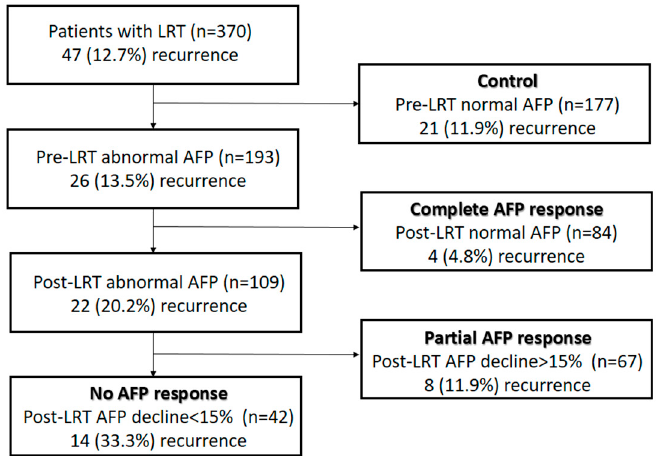
Figure 2. Flowchart of patient grouping according to AFP level, AFP response, and recurrence rates. The recurrence rates show the significant difference in the no AFP response group compared to the other three groups.